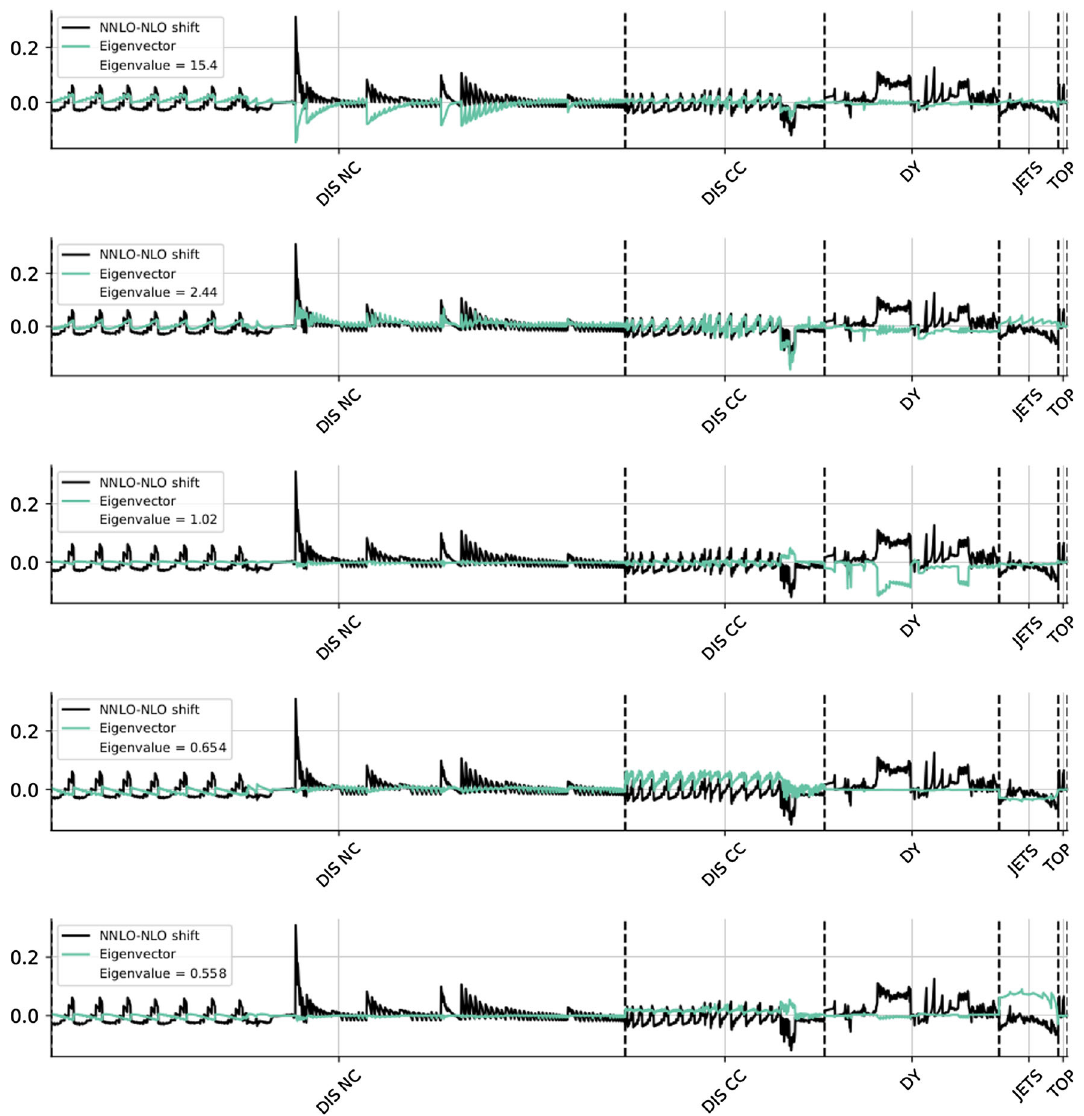
Fig. 14 The components e α (green) of the eigenvectors, corresponding to the five largest eigenvalues for the 9-point theory covariance matrix, i shown in the same format as Fig. 9. The NNLO-NLO shift, δ i (black), is shown for